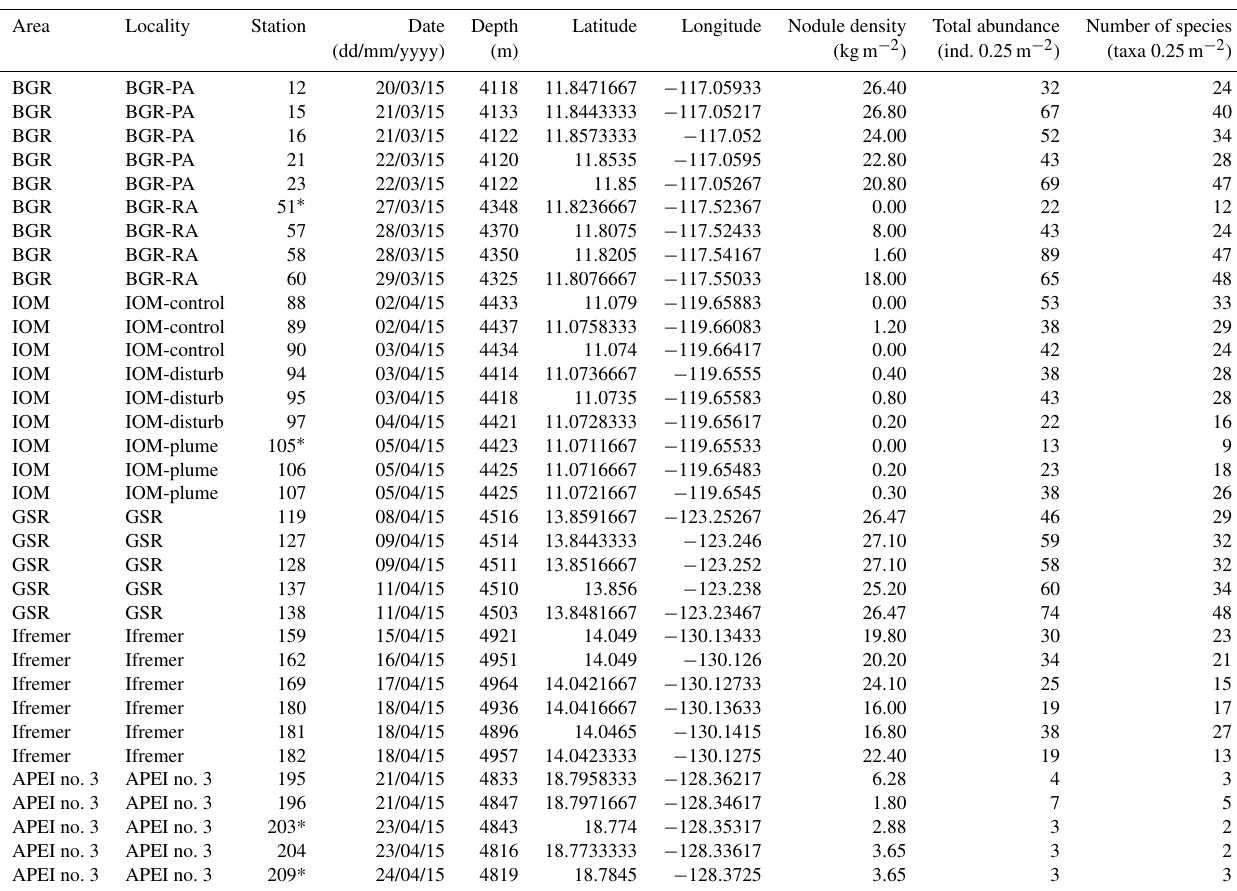
Table 1. Details of sampling, nodule density, total number of polychaete specimens (ind., individuals by box core) and number of polychaete species of all 34 box corer deployments across the CCFZ during the SO239 cruise. ∗ indicates box cores considered nonquantitative and thus not included in the